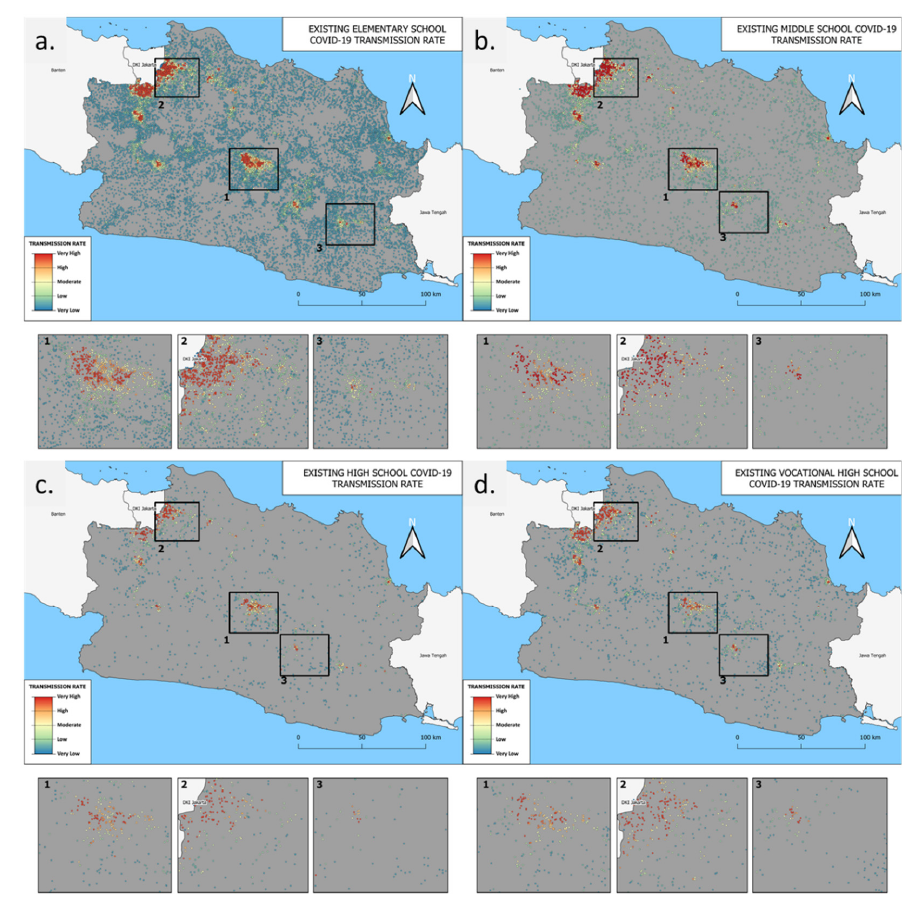
Figure 16. School Bio hazard (COVID 19) level for: (a) elementary, (b) junior high, (c) senior high, and (d) vocational high schools.